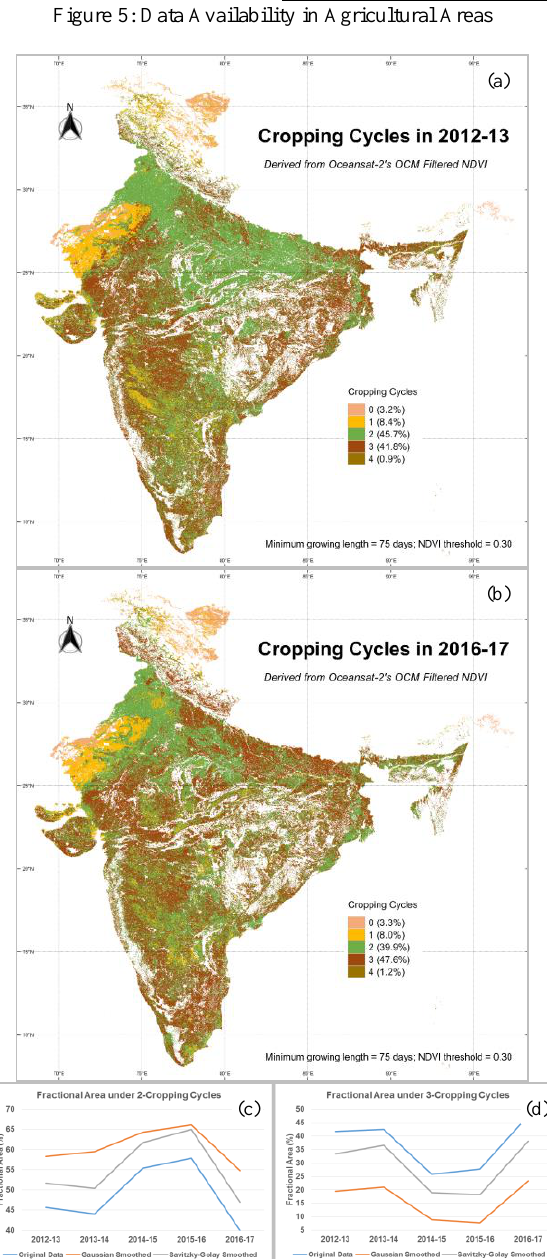
Figure 6: Cropping cycles derived from “peak detection” algorithm for (a) 2012-13 and (b) 2016-17; (c-d) shows the change in fractional area under 2-3 cropping cycles across 5 cropping years (2012-17) using original OCM NDVI time series & smoothed NDVI time series datasets